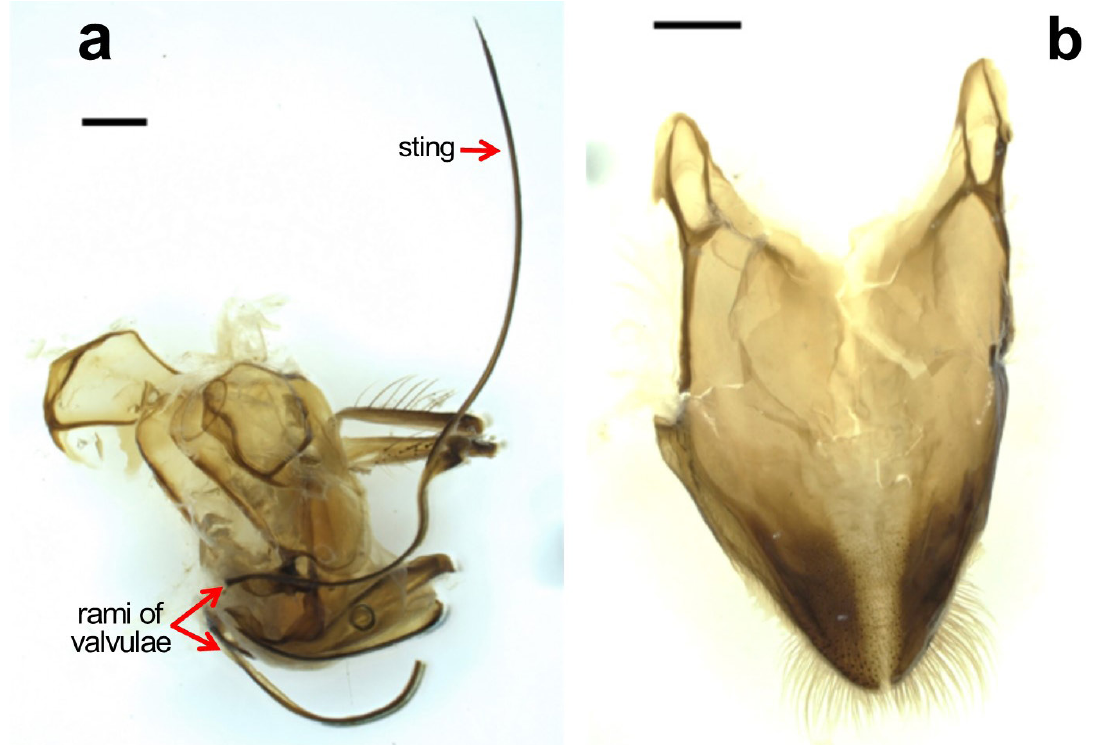
Fig 2. Terminalia of El. meriana gynander: a. Genitalia of gynander (in lateral view), sting emerges from the upper part of the genital capsule and not the lower one, b. Sternum 6 in dorsal view. Scale bars = 1